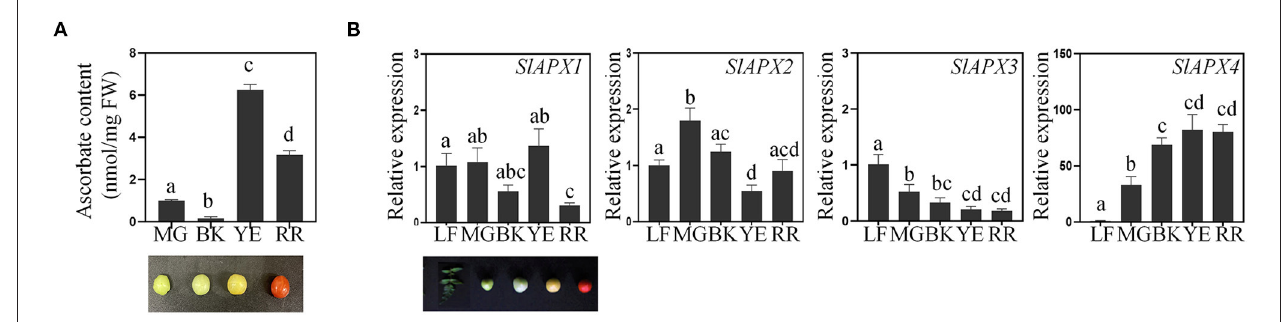
FIGURE 1 | Regulation of ascorbate accumulation during fruit development. (A) Change of ascorbate content during tomato fruit ripening. Ascorbate content (nmol per gram fresh weight) was determined from fruits at the indicated developmental stages. (B) The relative expression level of SlAPX s during fruit ripening. SlACT (Soly03g078400) was used as an internal control for normalization. Three tomato fruits from three individual plants at the indicated developmental stages were pooled for ascorbate quantification and gene expression analysis. Data represent the mean value + SD of three biological replicates. A significant difference was indicated with different letters above the bars (one-way ANOVA test). FW, fresh weight; MG, mature green; BK, breaking; YE, yellowing; RR, red ripening; LF, leaves.